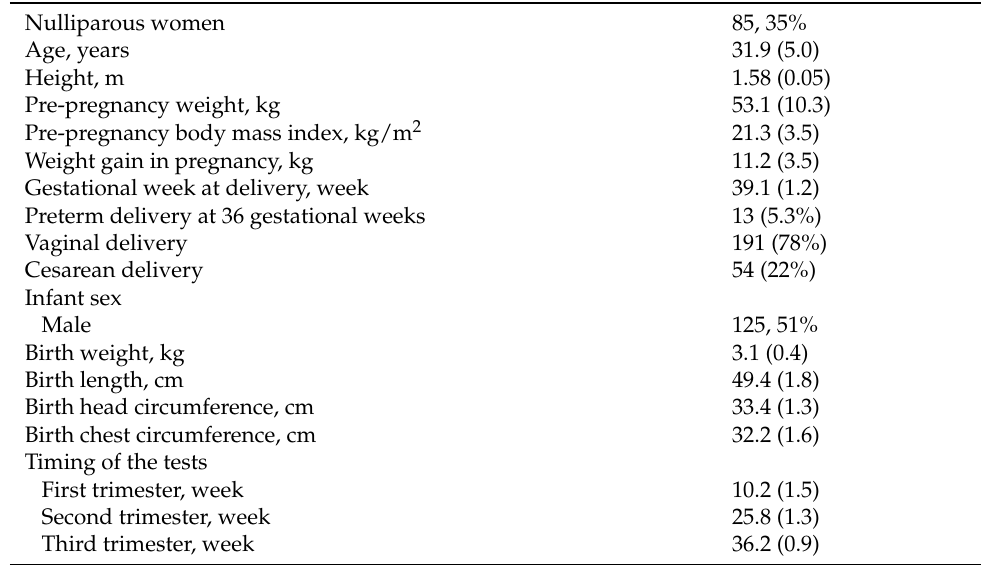
Table 1. Baseline characteristics of 245 pregnant women.